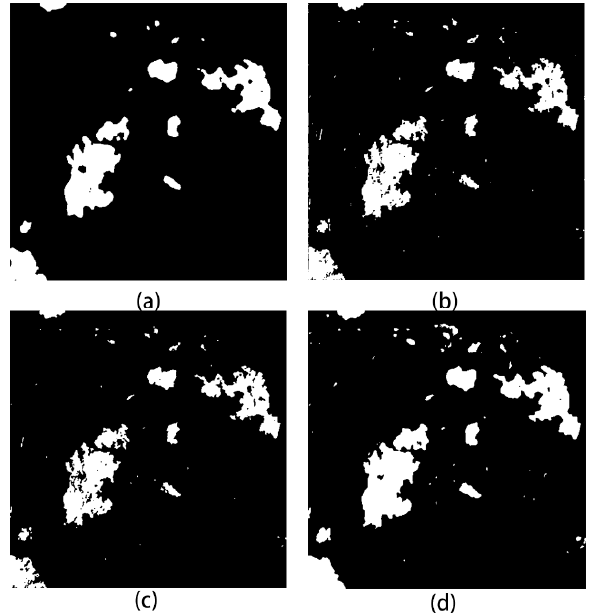
Figure 14. Mexico dataset: CDMs obtained by: ( a ) CD_PCA_Kmeans [1]; ( b ) CD_MLS [2]; ( c ) Semi_FCM method [3]; and ( d ) the proposed framework.